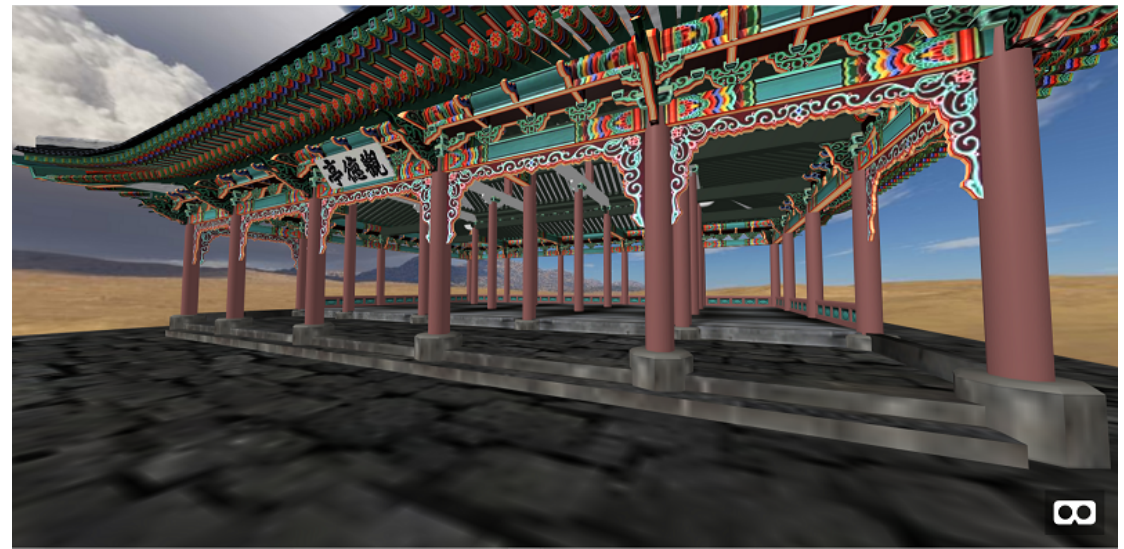
Figure 4. The VR component allows users to fully engage with the virtual environment and experience the artifact.